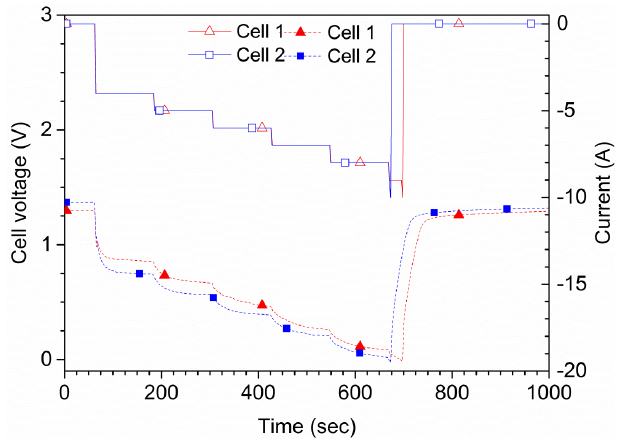
Figure 6. Voltage (filled symbols) and current (open symbols) measurements for current increment step for two different cells, cells 1 and 2.